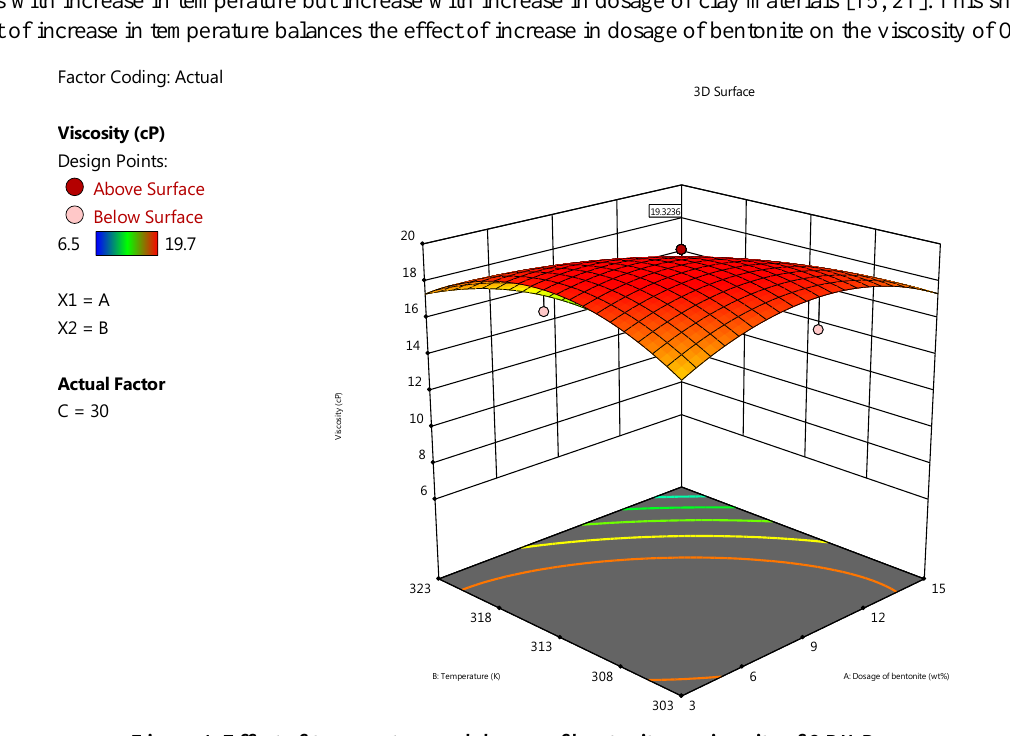
Figure 4. Effect of temperature and dosage of bentonite on viscosity of OBMB